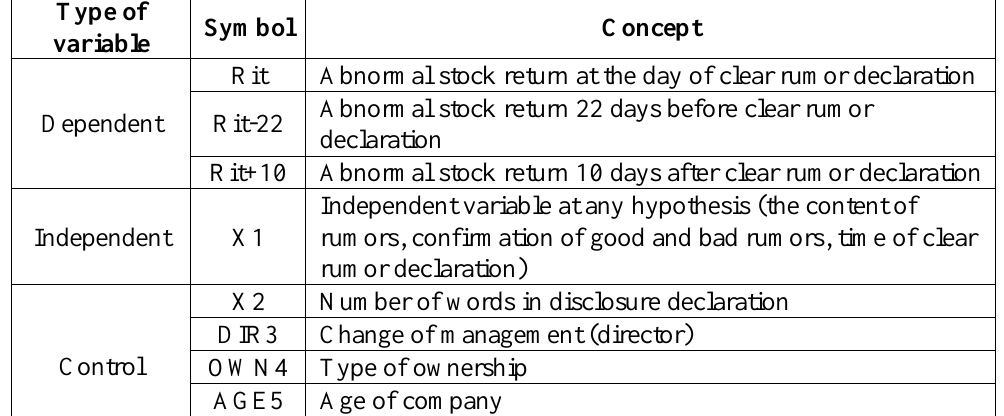
Table 3. Definition of the symbol used for regressive